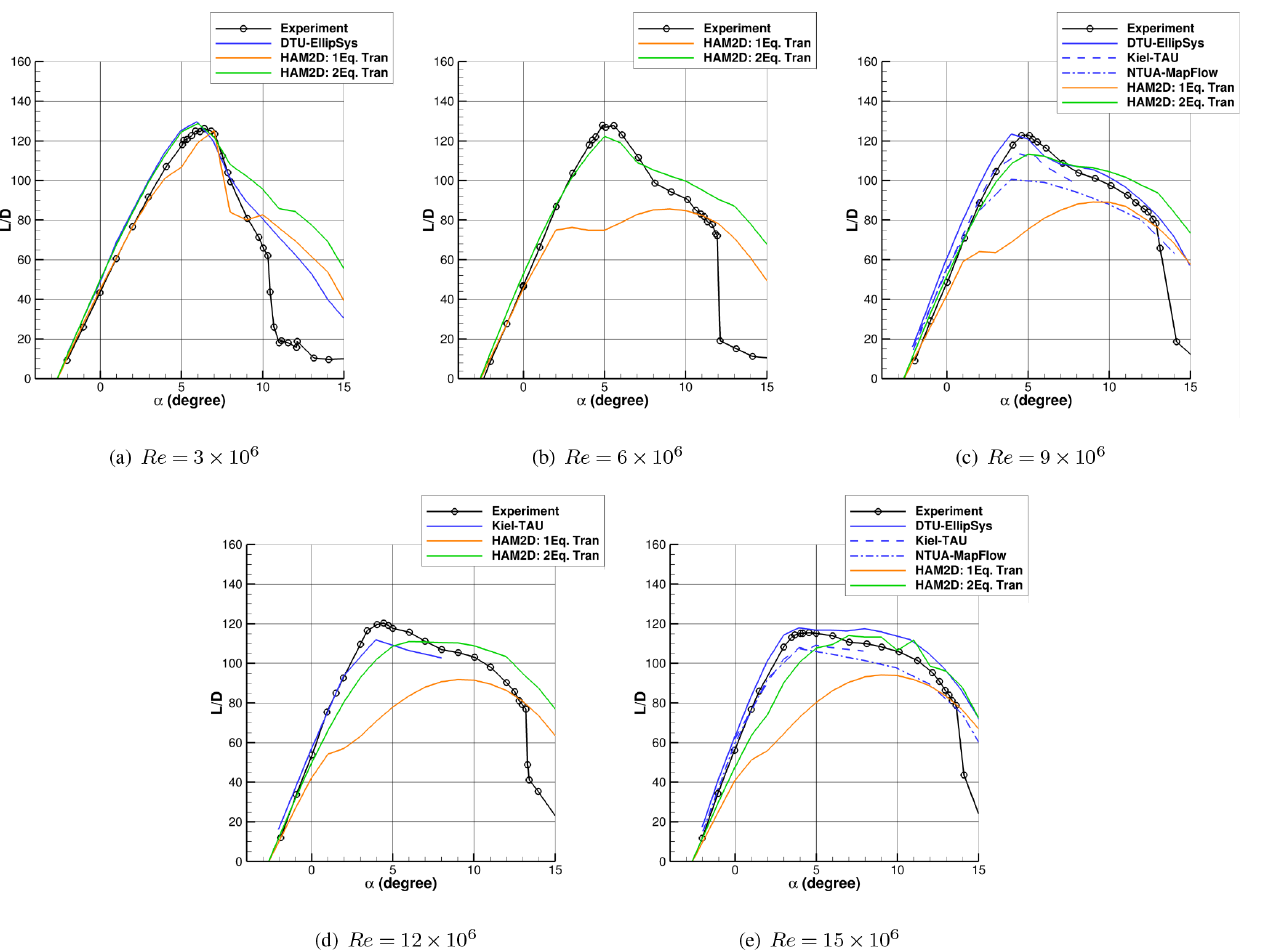
Figure 6. Comparison of the lift-to-drag ratio predicted by HAM2D using the one-equation and the two-equation transition models for the DU00-W-212 airfoil against experimental data from Ceyhan et al. (2017a). Simulation results using various transition models from DTU, Kiel, and NTUA (Ceyhan et al., 2017b) are also shown. All simulations are performed at a free-stream turbulent intensity corresponding to Ti3 from Table